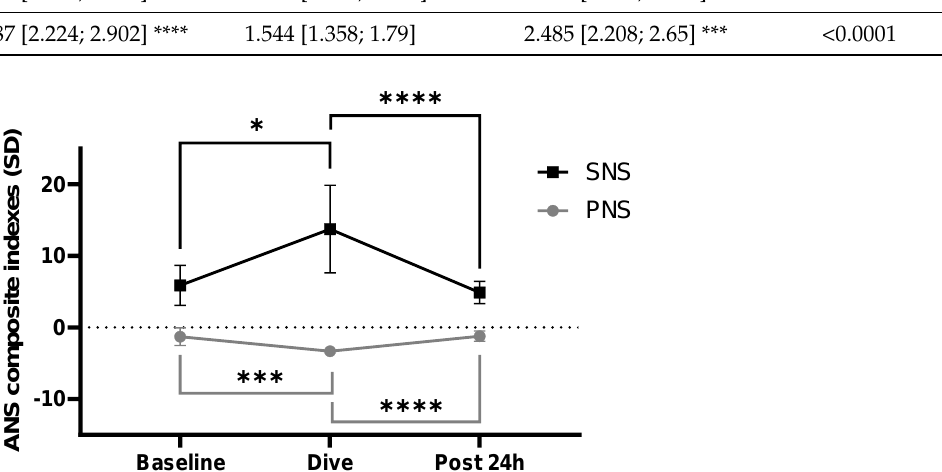
on immersion ( p < 0.001). Conversely, the SNS index varied to 5.570 [4.97; 6.62] at 13.5 [9.38; 19.72] ( p = 0.02). The PNS index decreased on immersion (F = 35.83, p < 0.0001) while the SNS increased (F = 23.74, p < 0.0001), as shown in Figure 4.